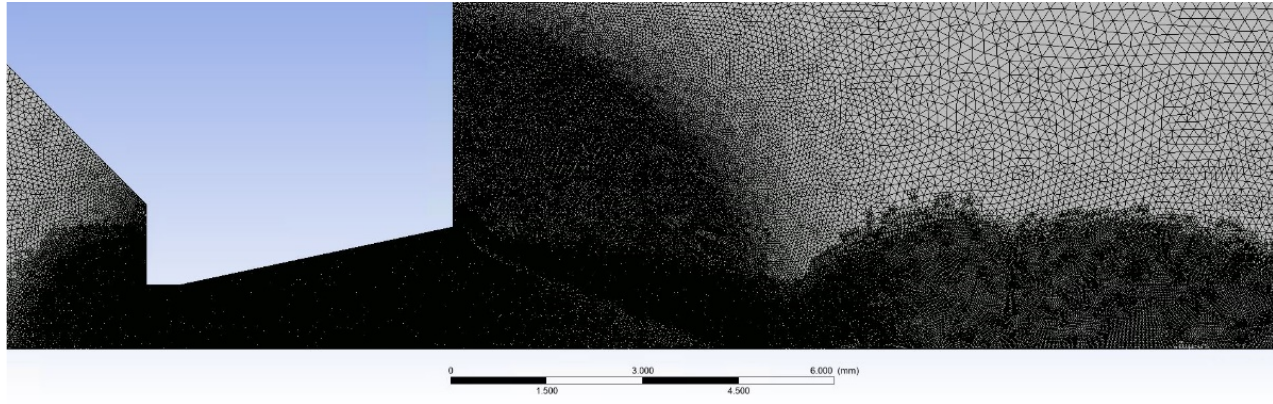
Figure 16. Detailed view of the area of the first shock wave behind the nozzle—zoomed.